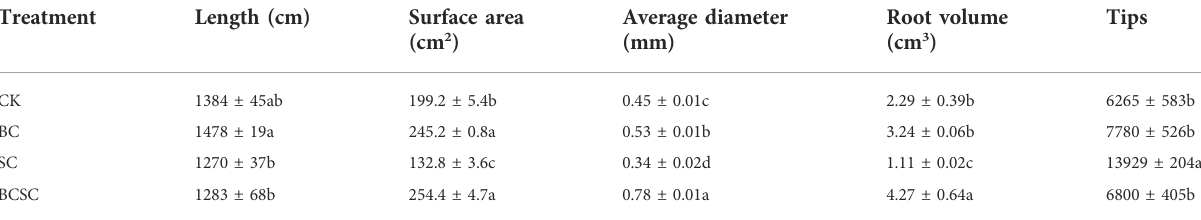
TABLE 2 Morphological indexes of the root system of sorghum treated with different additions.